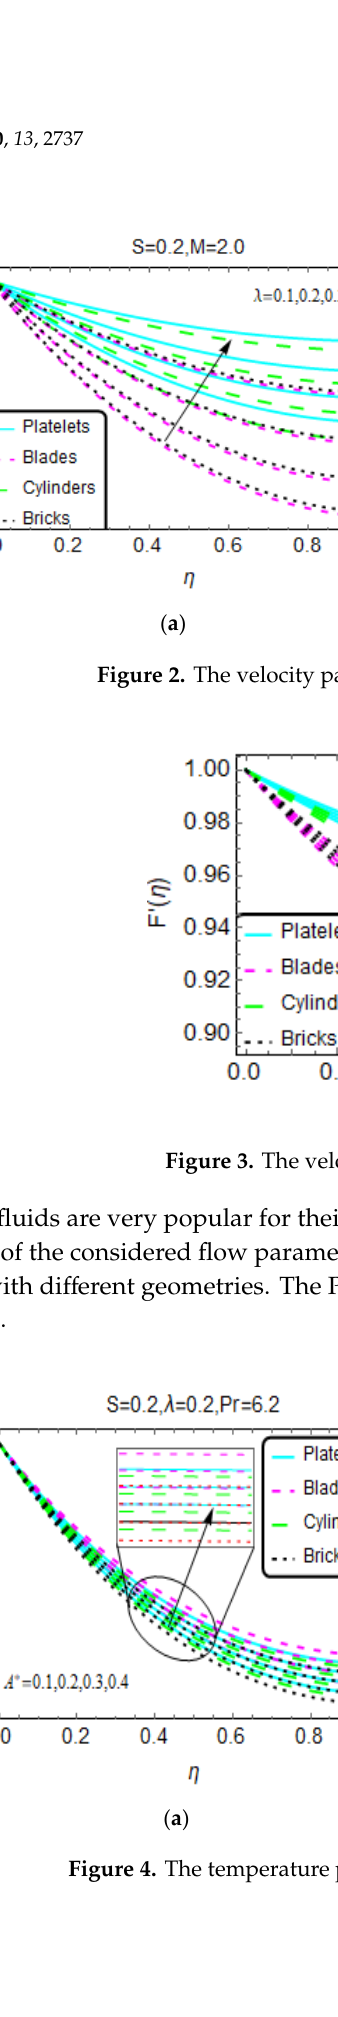
( b ) Figure 4. The temperature pattern for different values of ( a ) A ∗ and ( b ) B ∗ .